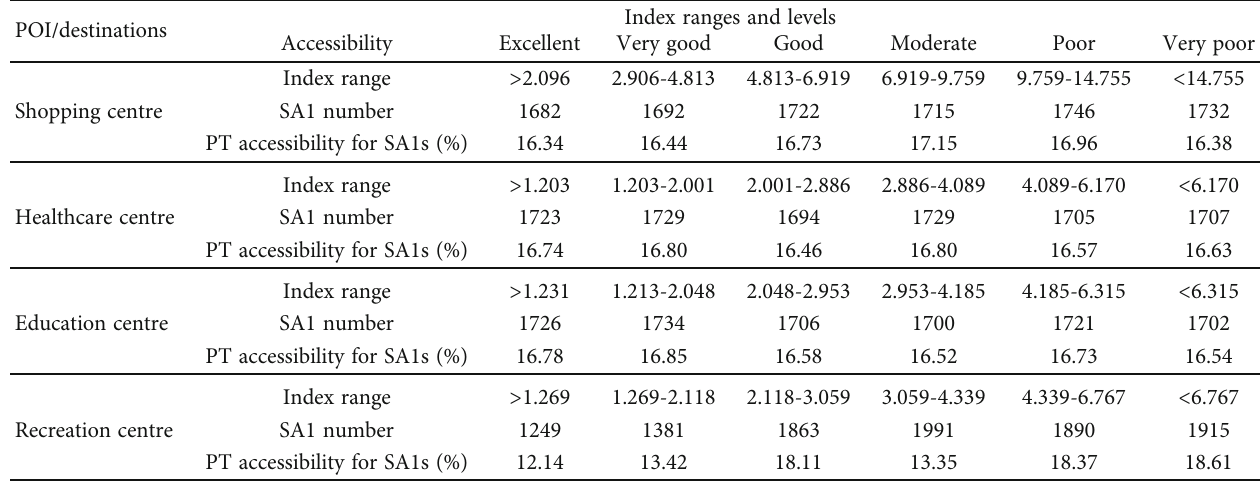
Table 8: Summary of elderly PT accessibility.